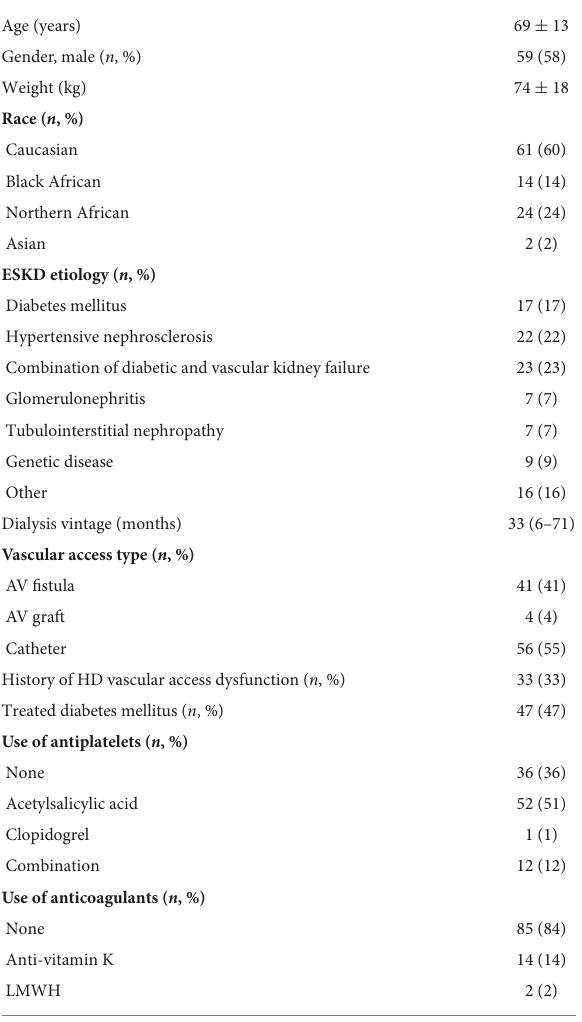
TABLE 1 Relevant demographic, medical and drug therapy data of the study